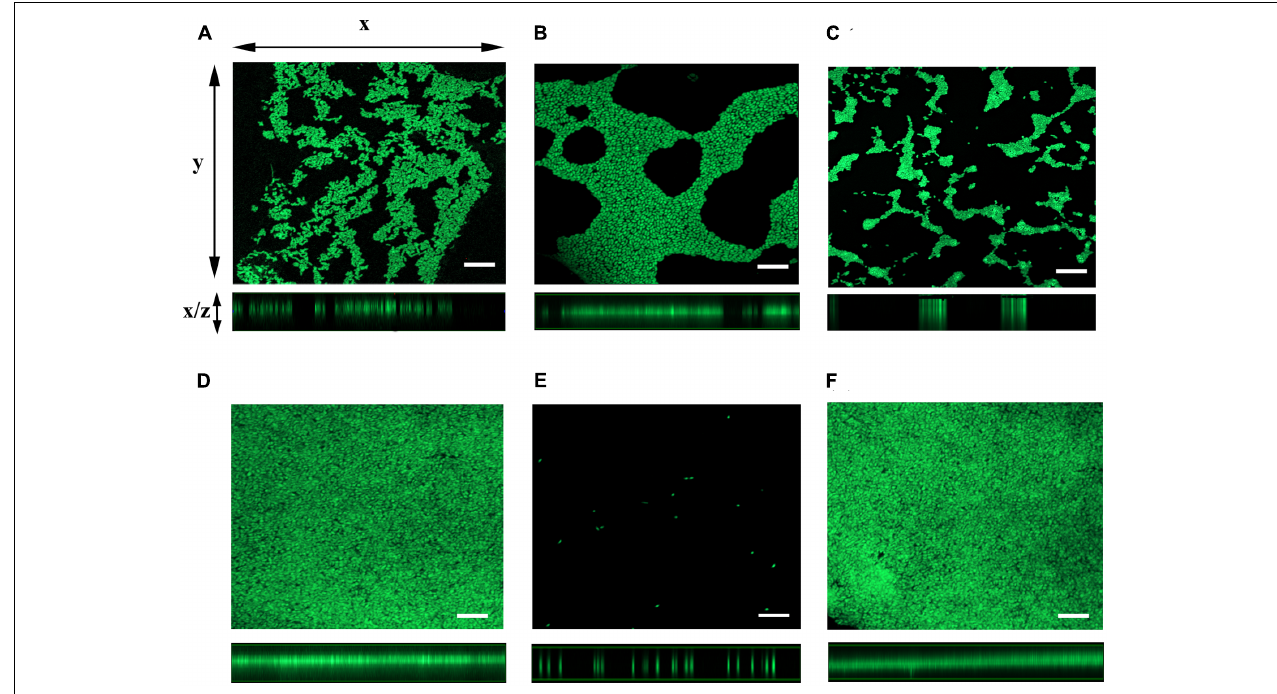
FIGURE 4 | Analysis of three-dimensional architecture of V. cholerae biofilm using confocal microscope. Each strain of interest was grown in a 12-well culture plate containing 600 µ l FSLW. A glass cover slip was dipped into each culture well and the cultures were incubated overnight statically at room temperature. SYTO 9 dye was added to the culture wells to stain the cover slip and the image was obtained using a laser scanning confocal microscope with an excitation and emission wavelengths of 484 and 500 nm, respectively. Images of x – y sections (top panels) of biofilm and x – z projections (bottom panels) of the same biofilm were captured and analyzed using ZEN 2 imaging software (Blue edition). (A) V. cholerae N16961S, (B) N16961S (cid:49) flrA , (C) N16961S (cid:49) flrA /pAA146, (D) GS (cid:49) flrA , (E) GS (cid:49) flrA (cid:49) mshA , and (F) GS (cid:49) flrA (cid:49) mshA /pAA159; bar-10 µ